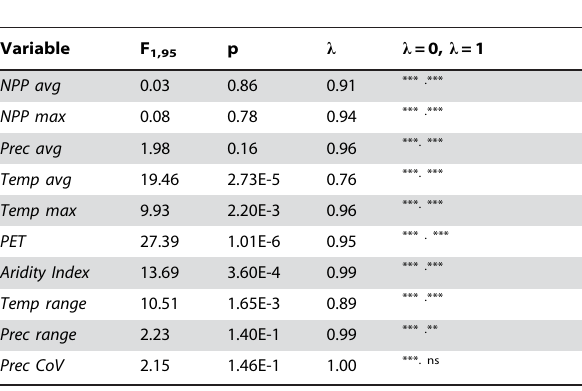
Table 3. Differences in environmental associations of migrants and